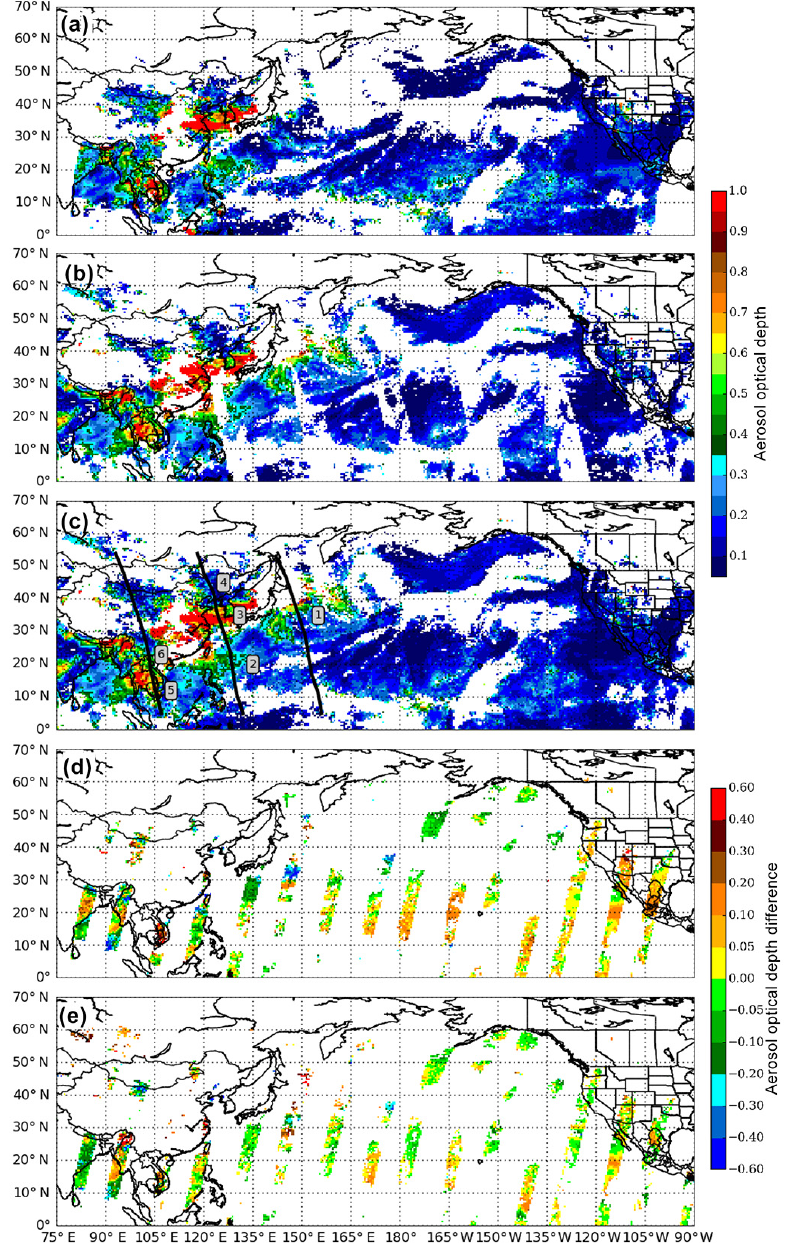
Figure 3. The top three panels display the daily AOD composites with central time at 00:00UTC on 18 March 2014. (a) Example of the daily AOD composite when only GEO retrievals are utilized, (b) example of when only LEO retrievals are utilized, (c) final version of our daily AOD composite product that combines all satellite retrievals onto the same map. (d) Difference plot between the GEO AOD retrievals and the available MISR AOD retrievals during the 24h period. (e) Difference plot between LEO AOD retrievals and MISR AOD.